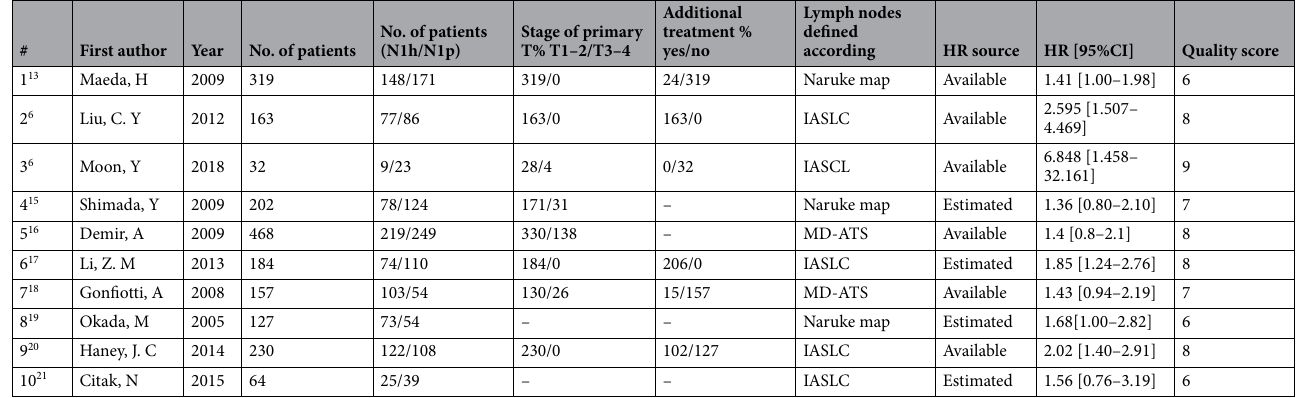
Table 1. Characteristics of the Studies Included in the